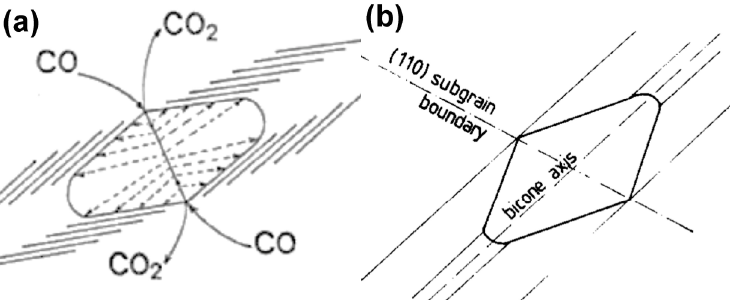
Figure 9. Schematic drawing of ( a ) bitube formation [41] and ( b ) disorientation (1° to 5°) of (110) subgrain boundary with respect to bicone axis [42]. Reprinted with permission from [41,42], Copyright 1985 Elsevier and Copyright 1982 Elsevier.